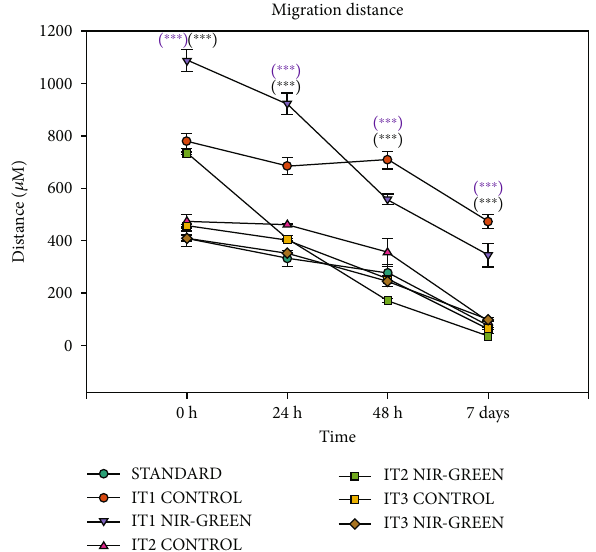
Figure 7: Migration analysis of transdi ff erentiated iADSCs 0 h, 24h, 48h, and 7 days post-PBM. The IT1 NIR-G PBM iADSCs signi fi cantly ( P < 0 : 0 01) migrated over time compared to the standard and